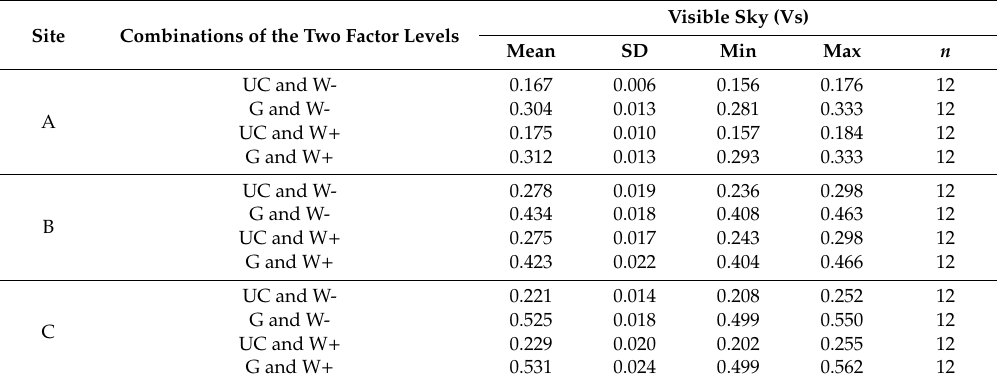
Table 1. Visible sky values in the plots of each of the two factor (sowing environment and water supplementation) level combinations in each of the three